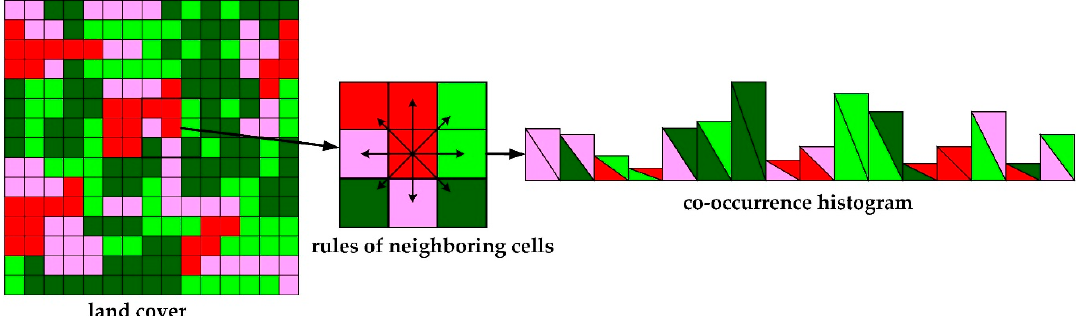
Figure 4. Examples of co-occurrence histogram extracted from land cover.